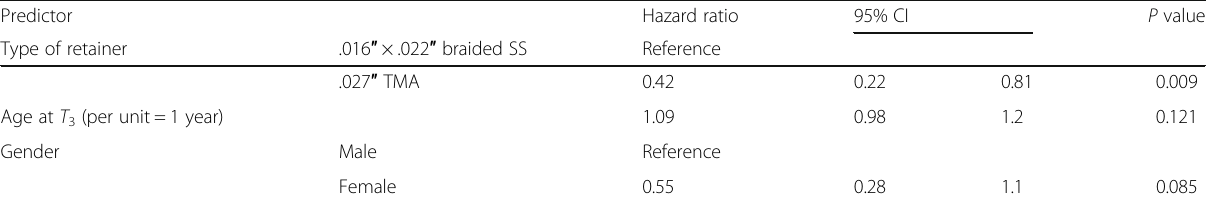
Table 4 Cox regression for the effect of retainer type on mandibular lingual retainer survival adjusted for age at T 3 and gender Predictor